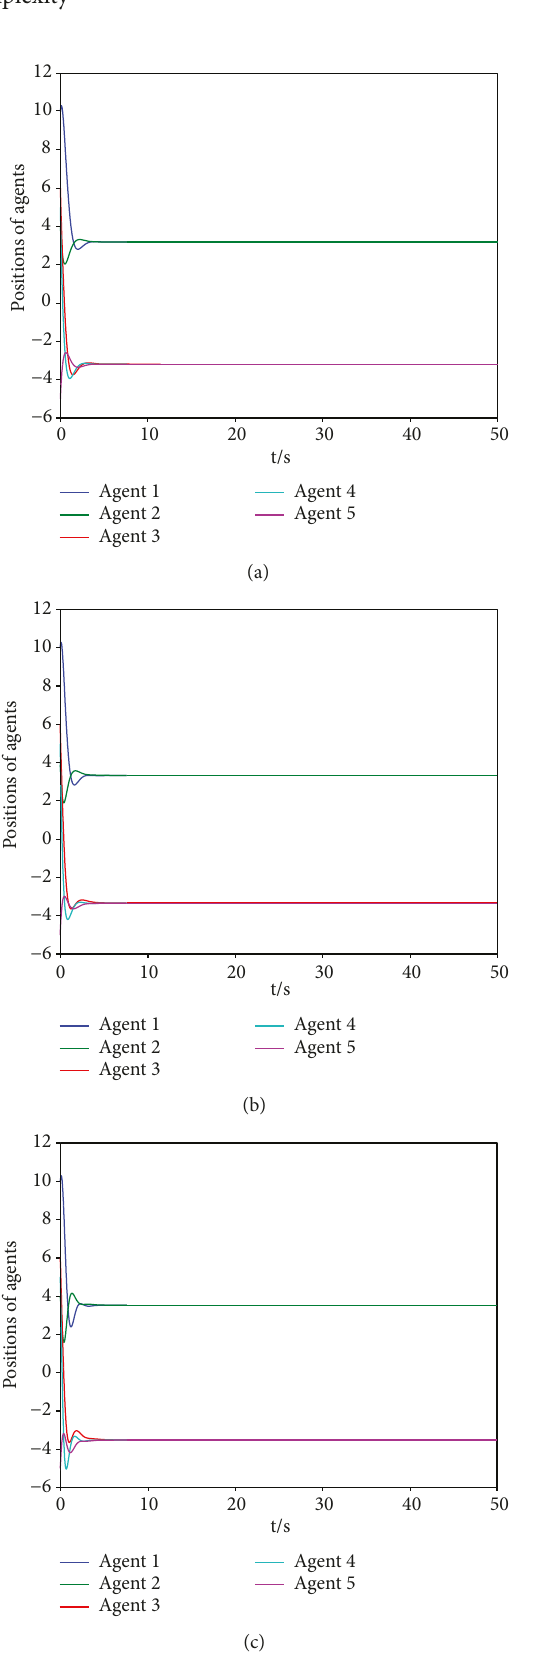
Figure 3: The agents ’ position trajectories, where τ τ = 0 , (b) τ = 0 1 , and (c) τ = 0 15 .